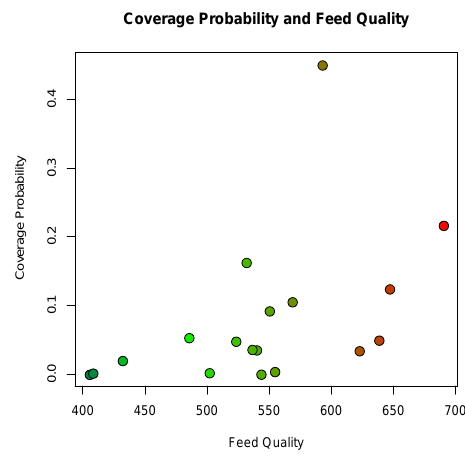
Figure 5: Coverage probability of canopy above 4 m and feed quality. Each point is a different location. Note that high coverage probability suggests higher feed value, but coverage probability doesn’t discriminate between high feed locations and moderate feed locations.